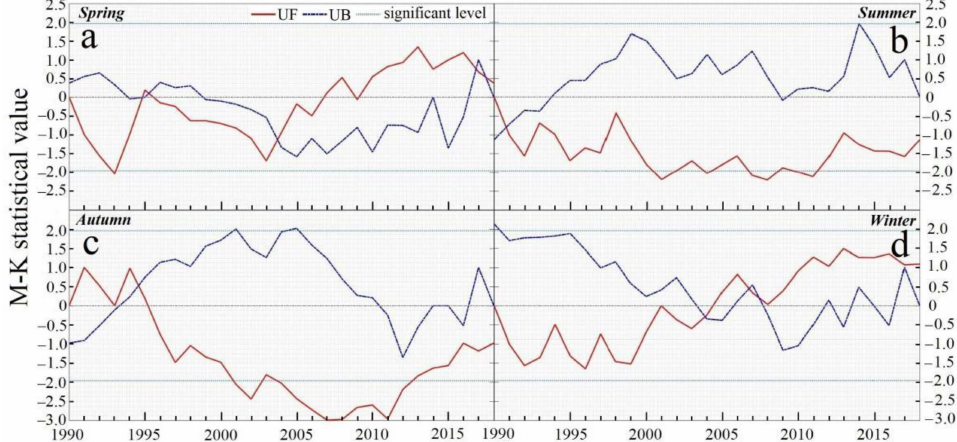
Figure 9. Mann–Kendall statistical test for quarterly variations in spring ( a ), summer ( b ), autumn ( c ), and winter ( d ) based on SPEI03 in northeast China (NEC) from 1990 to